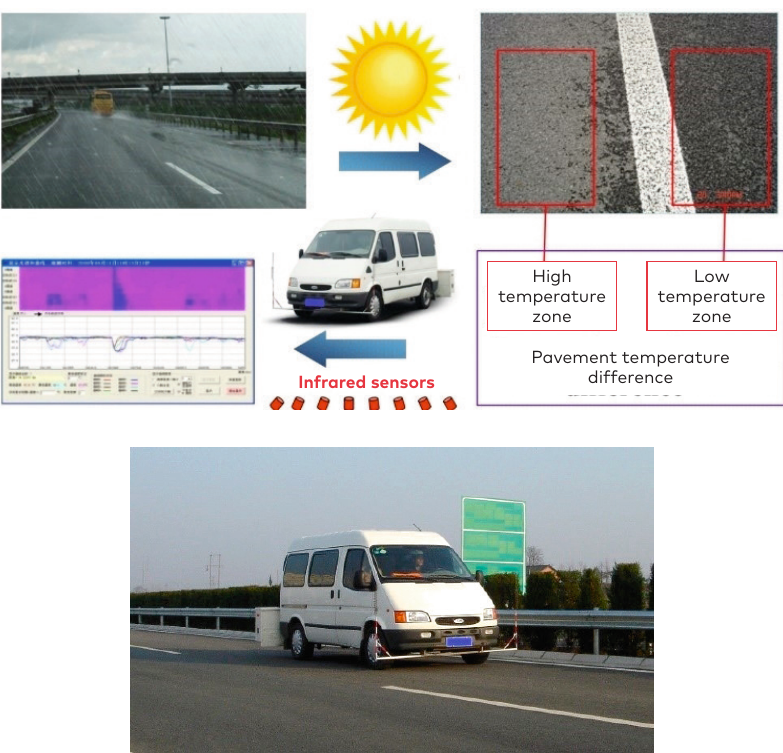
Figure 1. Assessment of water permeability of road asphalt